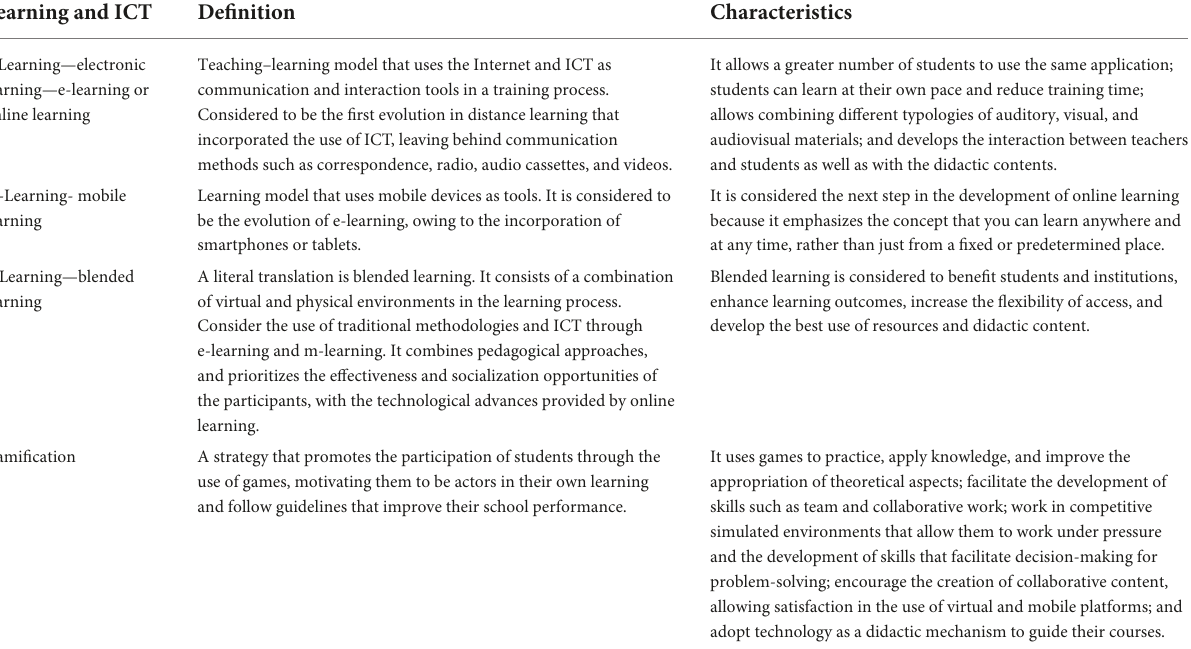
TABLE 2 Description of different types of educational models based on the learning and ICT associated with them (adapted from Zydney and Warner, 2016; Huang and Hew, 2018; Romero and Quintero, 2018; Bajpai et al., 2019; Guzmán-Duque et al., 2020). Learning and